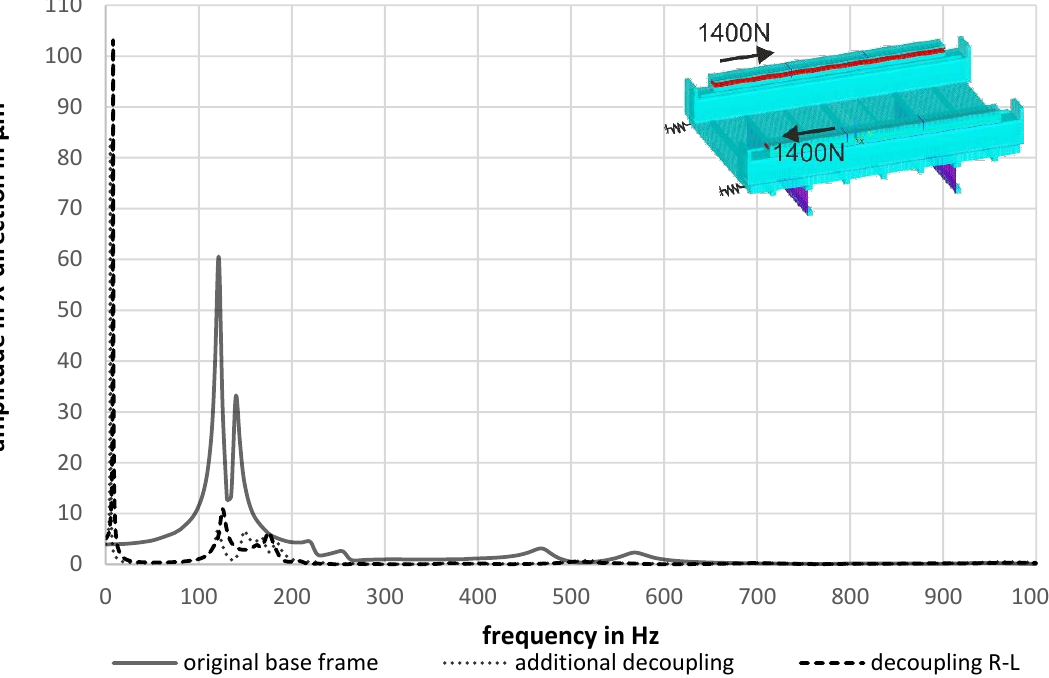
Figure 7. Frequency response of the frame vibration amplitude in X-direction (at the location of the accelerometer, see Figure 2), excited by identical drive forces acting in opposite directions on the right and left sides (compensation right–left).